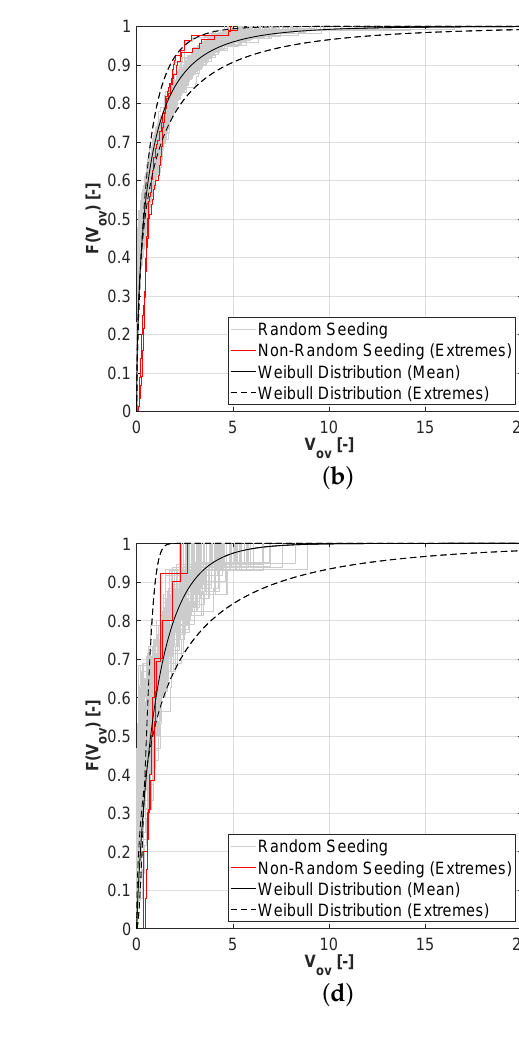
Figure 10. Cumulative density functions showing distributions of individual overtopping volumes for smooth slope. ( a ) TS01-SS; ( b ) TS05-SS; ( c ) TS02-SS; ( d )